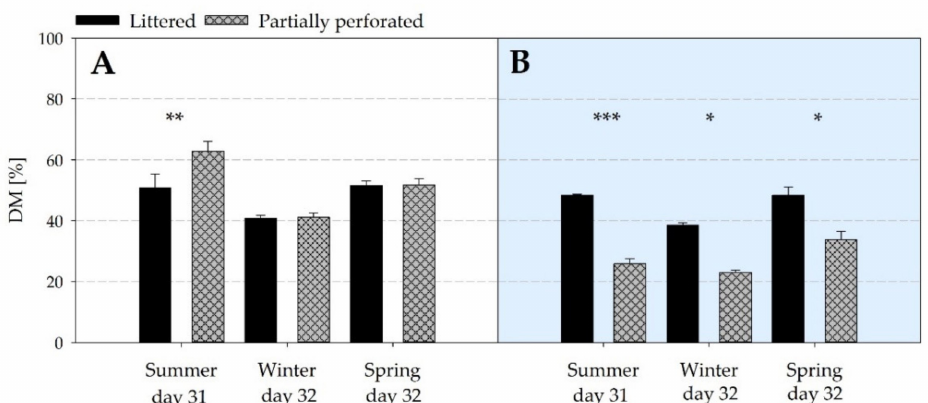
Figure 9. Average dry matter (DM) contents of litter samples from ( A ) the littered side areas and ( B ) the supply area from broiler houses with two different floor types at the end of each of the three different fattening periods ( n = 6 values per fattening period and barn in area ( A ); n = 3 values per fattening period and barn in area ( B )). Significant differences are marked by asterisks: * p ≤ 0.05, ** p < 0.01, *** p < 0.001.